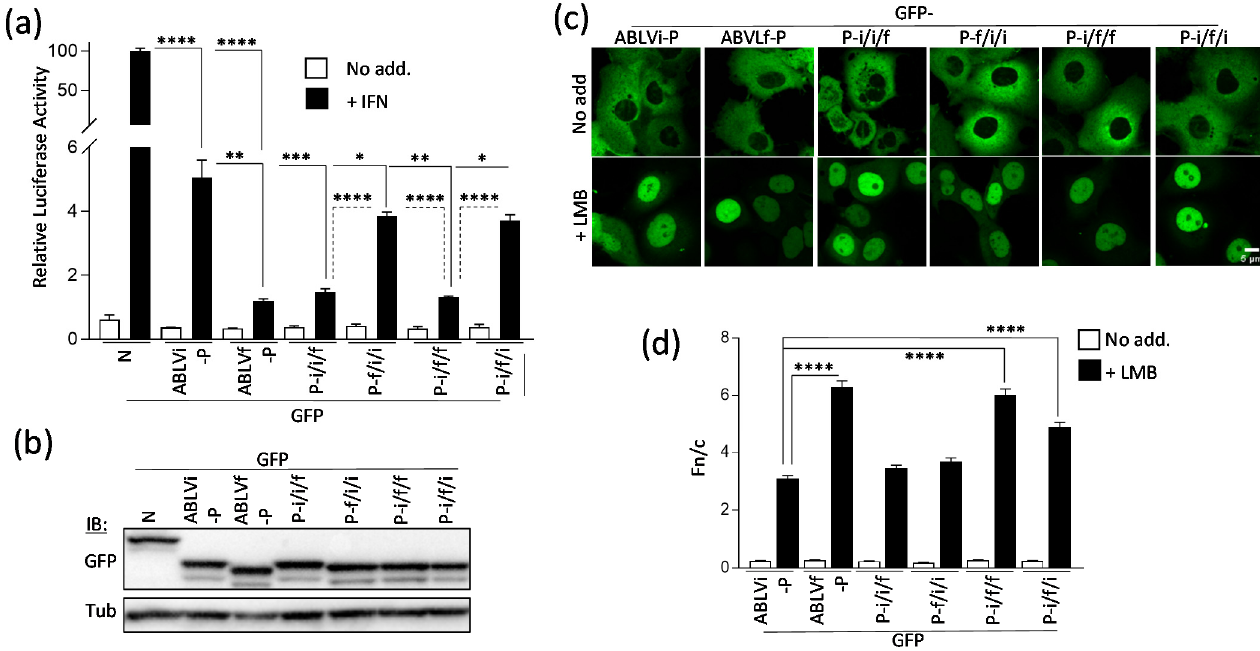
Figure 2. P proteins of ABLVi and ABLVf differ in STAT1 antagonist function and nuclear trafficking. ( a ) 293T cells were transfected to express the indicated proteins and with plasmids for the IFN α /STAT1-dependent dual-luciferase reporter assay before treatment with or without 1000 U/mL IFN α (16 h) and calculation of luciferase activity (ratio of firefly/ Renilla activity; mean ± SD). **** p < 0.0001, *** p ≤ 0.001, ** p ≤ 0.01, * p ≤ 0.05 (Student’s t -test); data representative of ≥ 3 assays. ( b ) Expression of GFP and tubulin (Tub., loading control) in lysates from reporter assays was determined by immunoblotting (IB) using the indicated antibody. ( c ) Cos-7 cells expressing the indicated proteins were treated with or without 5.2 nM leptomycin-B (LMB) before analysis by confocal laser scanning microscopy (CLSM). ( d ) Images such as those in ( c ) were analyzed to calculate the ratio of nuclear to cytoplasmic fluorescence (Fn/c, mean ± SEM). **** p < 0.0001, n > 40 cells for each condition.